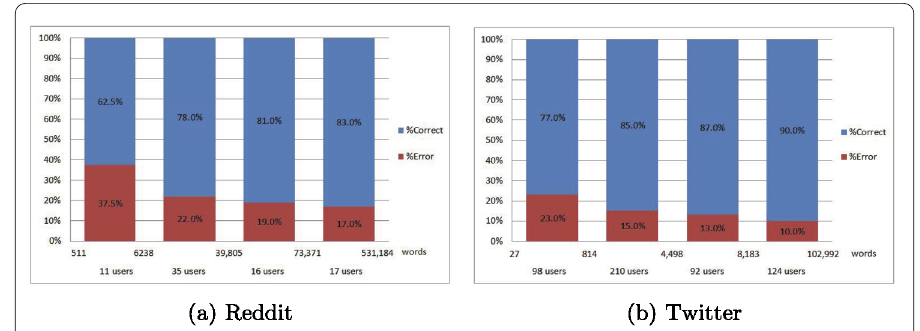
Figure 5 Percentages of classification errors by users’ history lengths (number of posts), in the Reddit and Twitter collections. The statistics correspond only to users from the positive class (i.e., depressed